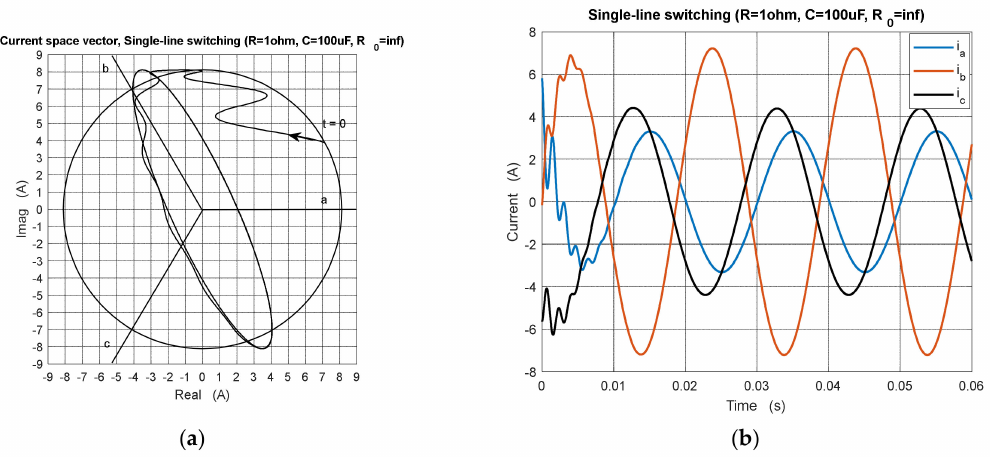
Figure 11. Single-line switching of phase a . Time-behavior of the current space vector ( a ) and the related phase currents ( b ) for the three-phase circuit in Figure 10 where S operates single-line switching of phase a with an impedance Z consisting in a capacitor C = 100 µ F. The single-phase circuit is open since R 0 → ∞ .